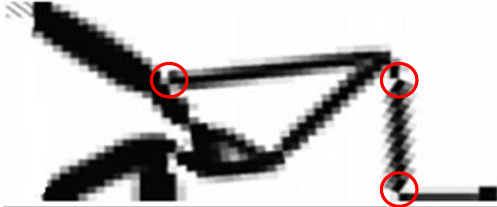
Figure 6. An optimal topology for a path-following CM from F16 (Pederson et al.,